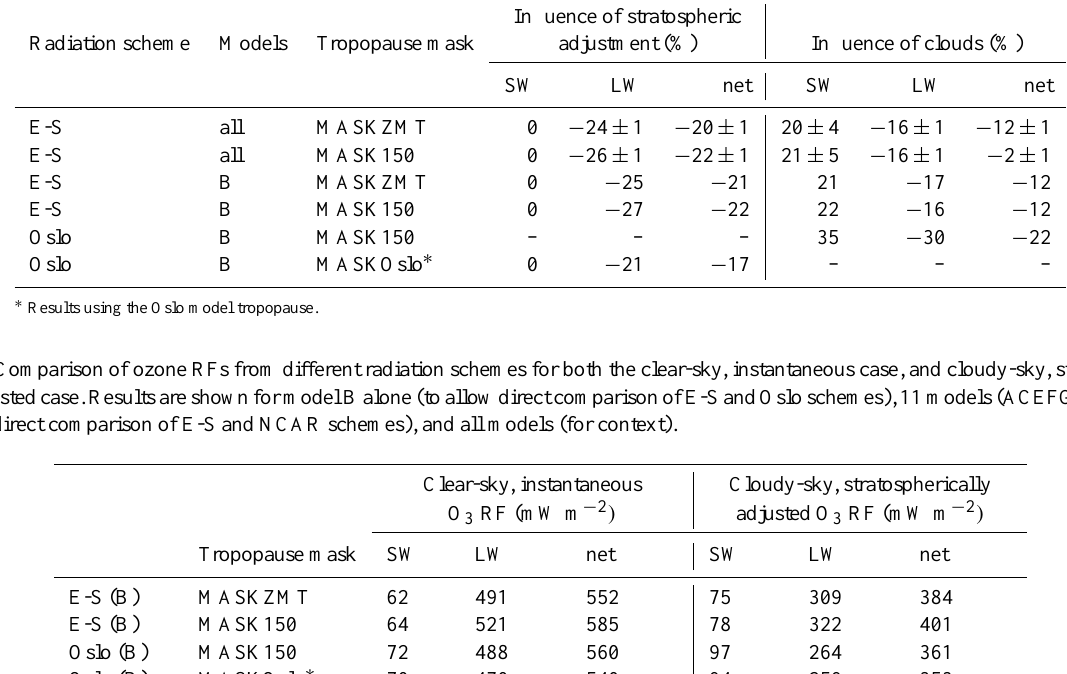
Table 4. Influence of stratospheric adjustment and clouds (% change in ozone RFs when included) in the Edwards-Slingo (E-S) and Oslo schemes. First two rows are for all models: values are means and standard deviations. Lower rows are just for model B.